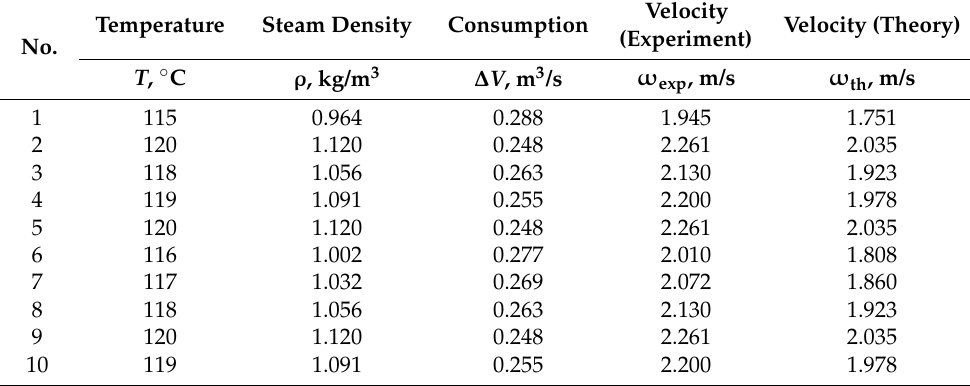
Table 2. Comparison of vapor phase velocities based on theoretical and experimental data for the external